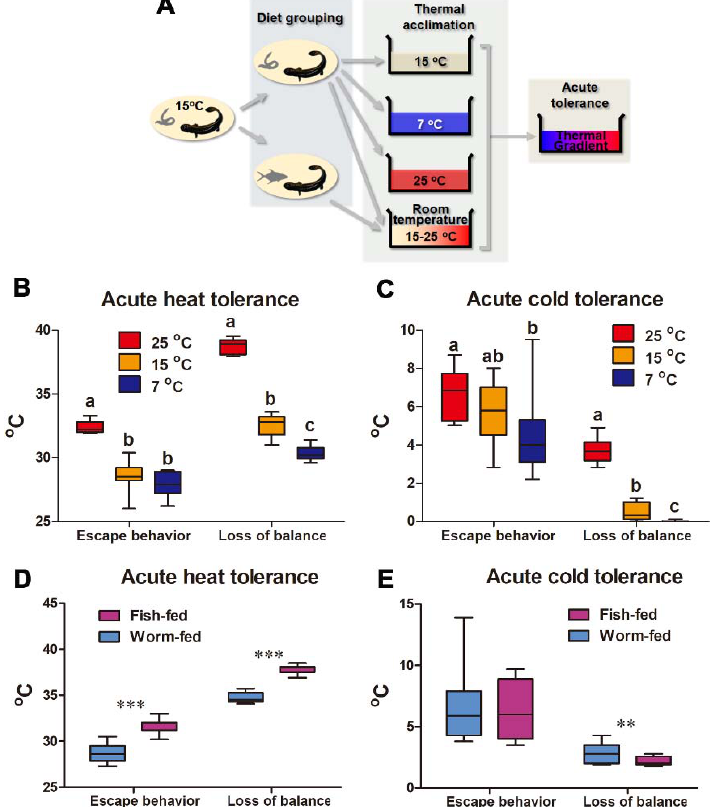
Figure 2. Plasticity in thermal limits after thermal and diet acclimation. ( A ) Experimental design. ( B , C ) Variations between thermal-acclimated groups. Different letters denote significant differences ( p < 0.05) between groups; Kruskal–Wallis test. ( D , E ) Variations between diet-acclimated groups. The differences between worm and fish diets were analyzed by Mann–Whitney U test; **, p < 0.01; ***, p <